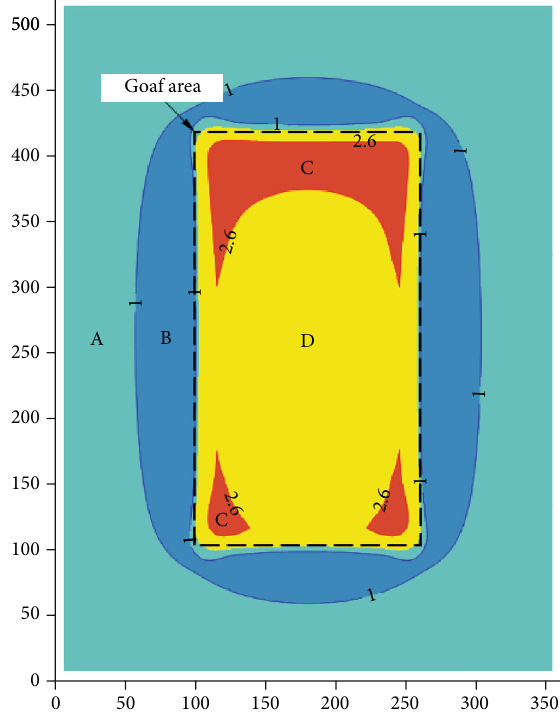
Figure 10: 2D diagram of bidirectional stress ratio zoning